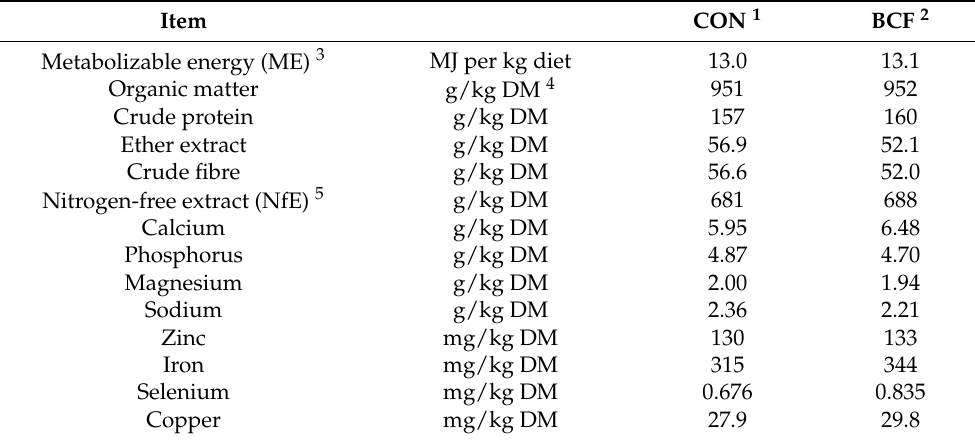
Table 2. Energy content and chemical composition of the experimental